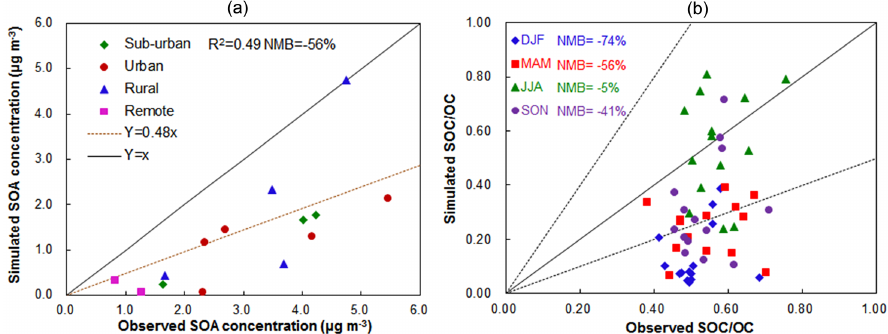
Figure 3. (a) Simulated vs. observed mean July–September SOA concentration. Observations are from Ding et al. (2014). Also shown is the 1:1 line (solid line) and linear fit (dashed); NMB is the normalized mean bias between simulated and observed concentrations; (b) simulated vs. observed ratio of secondary organic carbon (SOC) to total organic carbon (OC) in China. The observed ratios are from Zhang et al. (2012). Also shown are the 1:1 line (solid line), 2:1 line and 1:2 line (dashed).